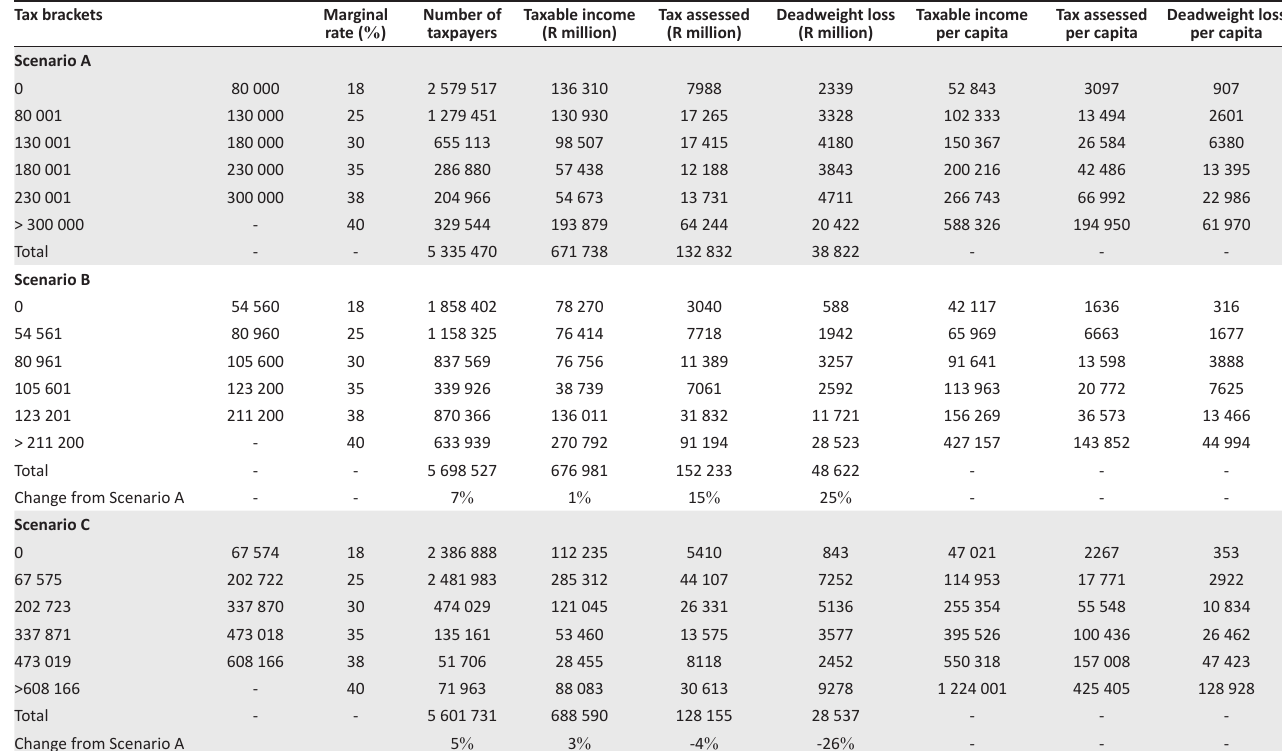
TABLE 6: Income brackets, number of taxpayers, tax, and deadweight loss. Tax brackets